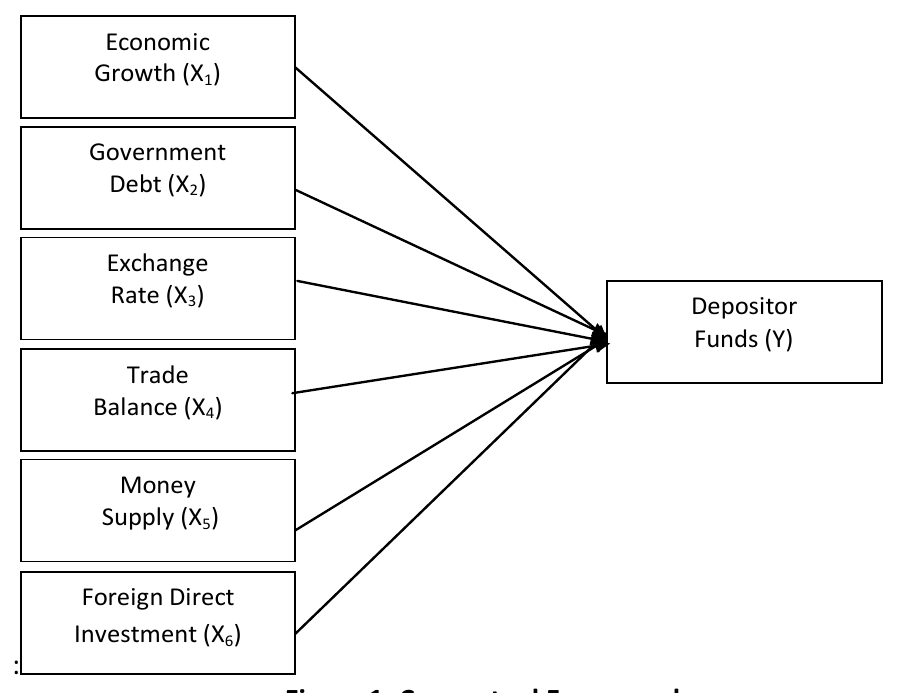
Figure 1: Conceptual Framework